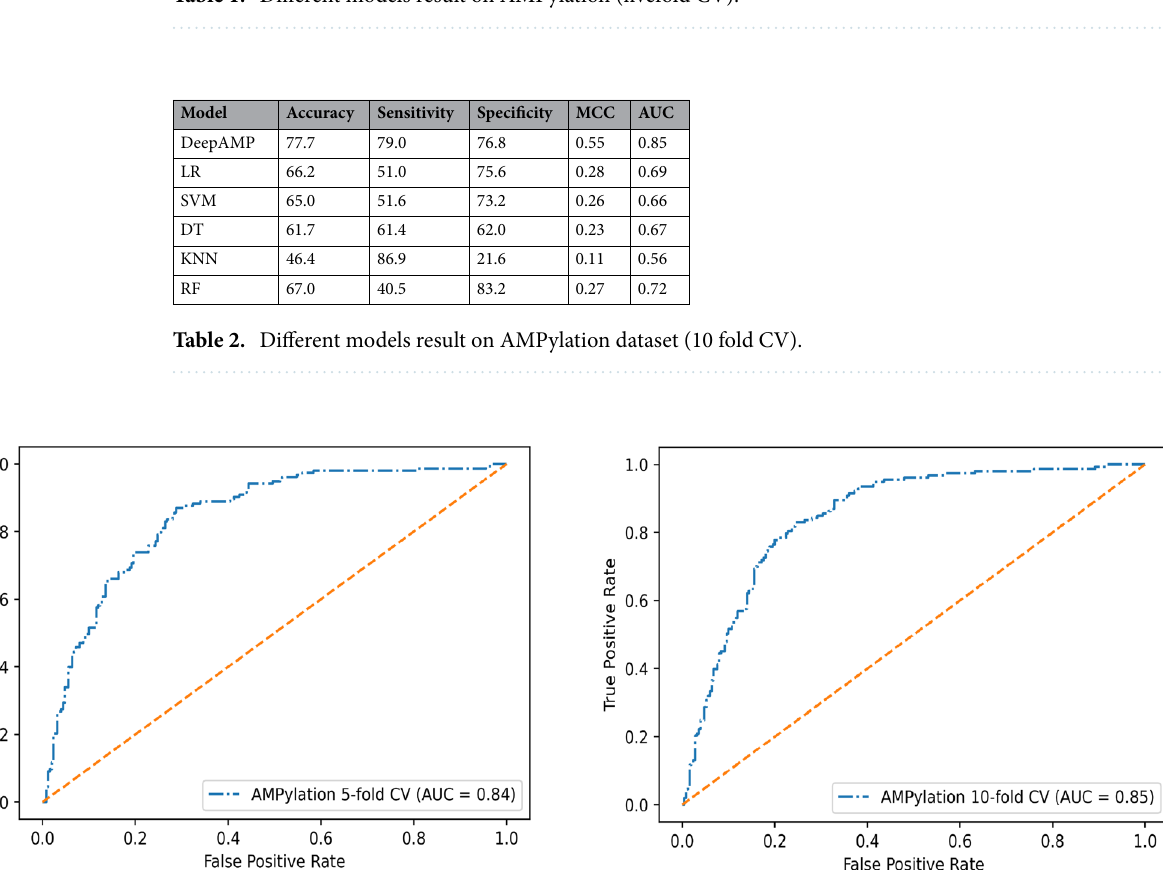
Table 1. Different models result on AMPylation (fivefold CV).